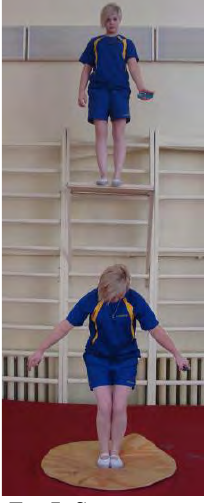
Fig.7. Space orientation test